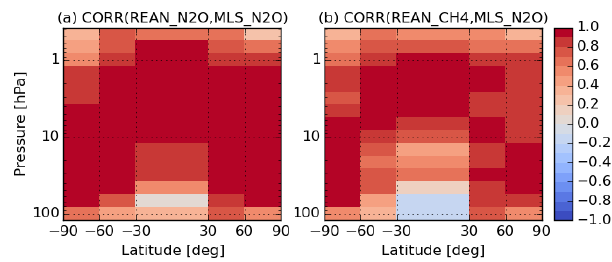
Figure 11. Correlation coefficients between (a) MLS N 2 O and REAN N 2 O, and (b) MLS N 2 O and REAN CH 4 as a function of latitude and pressure for the period October 2007–April 2012.